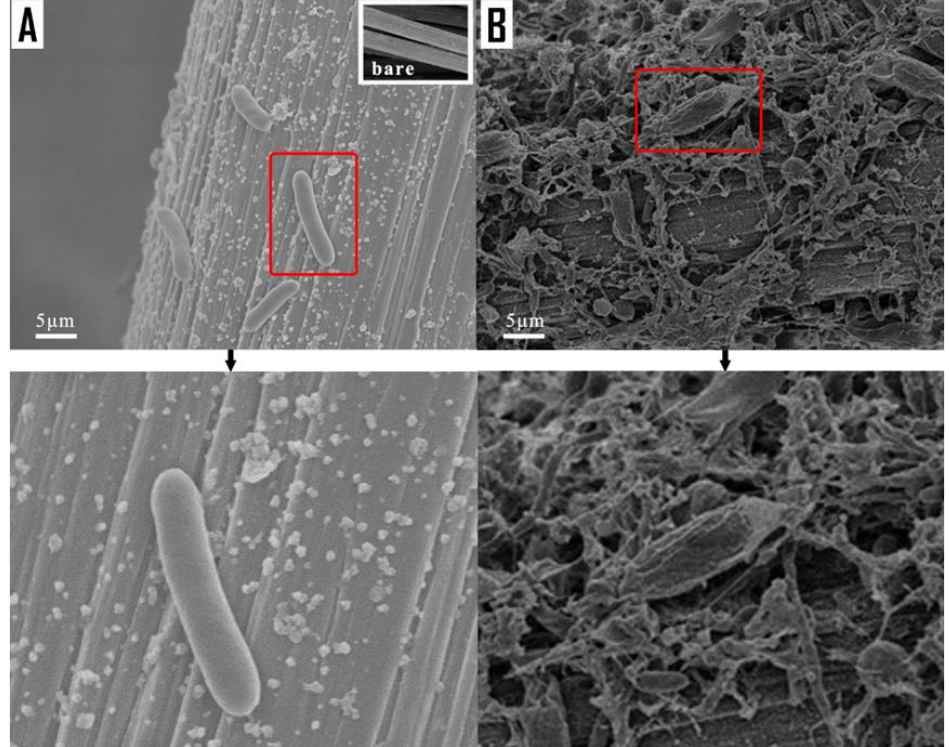
Figure 6. ( A ) Surface morphology of HR-1-inoculated MFC and the bare anode; ( B ) Plump cells on the anode with trehalose lipid. The plotting scale was 5 μm on anode carbon cloth.